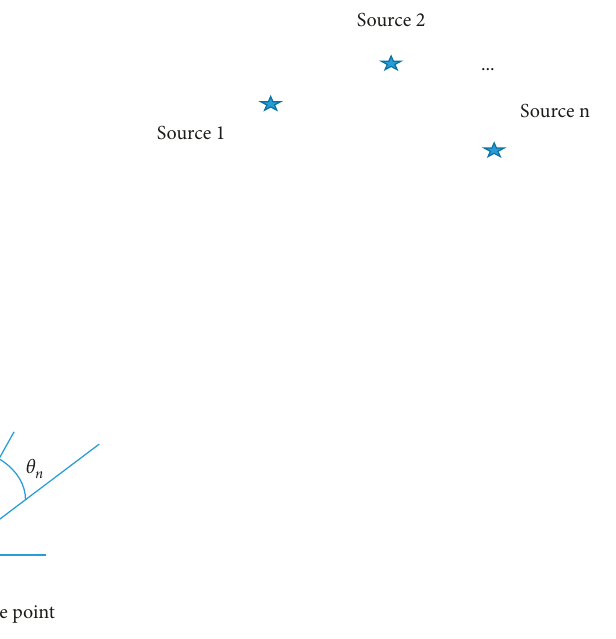
Figure 1: The solution of SML, ESPRIT, and the rough search